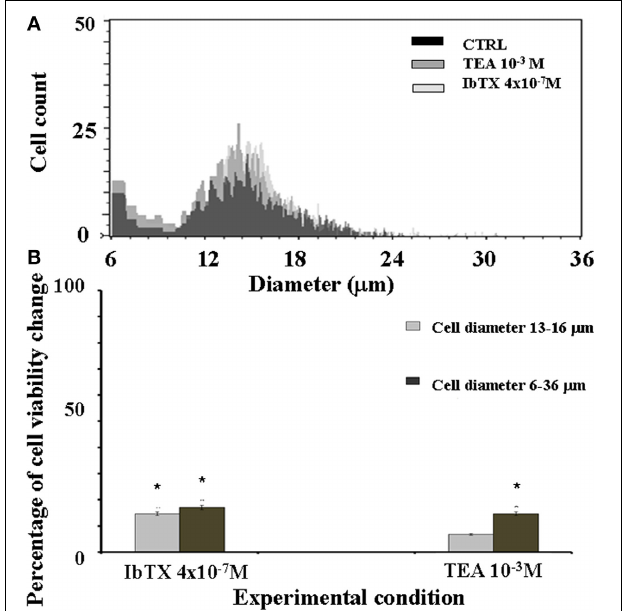
FIGURE 5 | SH-SY5Y neuronal cell distribution in the presence or absence of the BKCa channel blockers IbTX and TEA. The effects of the IbTX and TEA on the cell volume were investigated. The cellular distribution followed a Gaussian type distribution (A) The most frequently observed cell population in our experimental condition showed a diameter size in the range of 13–16 μ m as determined by cell volume assay. The mean cell diameter did not significantly differ between treatments, the values were 14.89 ± 1 in the controls (CTRL) and were 15.02 ± 2 and 14.5 ± 1, respectively, in the cells treated with IbTX and TEA (B) After 6h of incubation time the number of the cells showing a diameter size in the range of 13–16 μ m was significantly enhanced by IbTX and TEA. ∗ Data significantly different with respect to the controls for p < 0 . 05 as determined by student t -test.